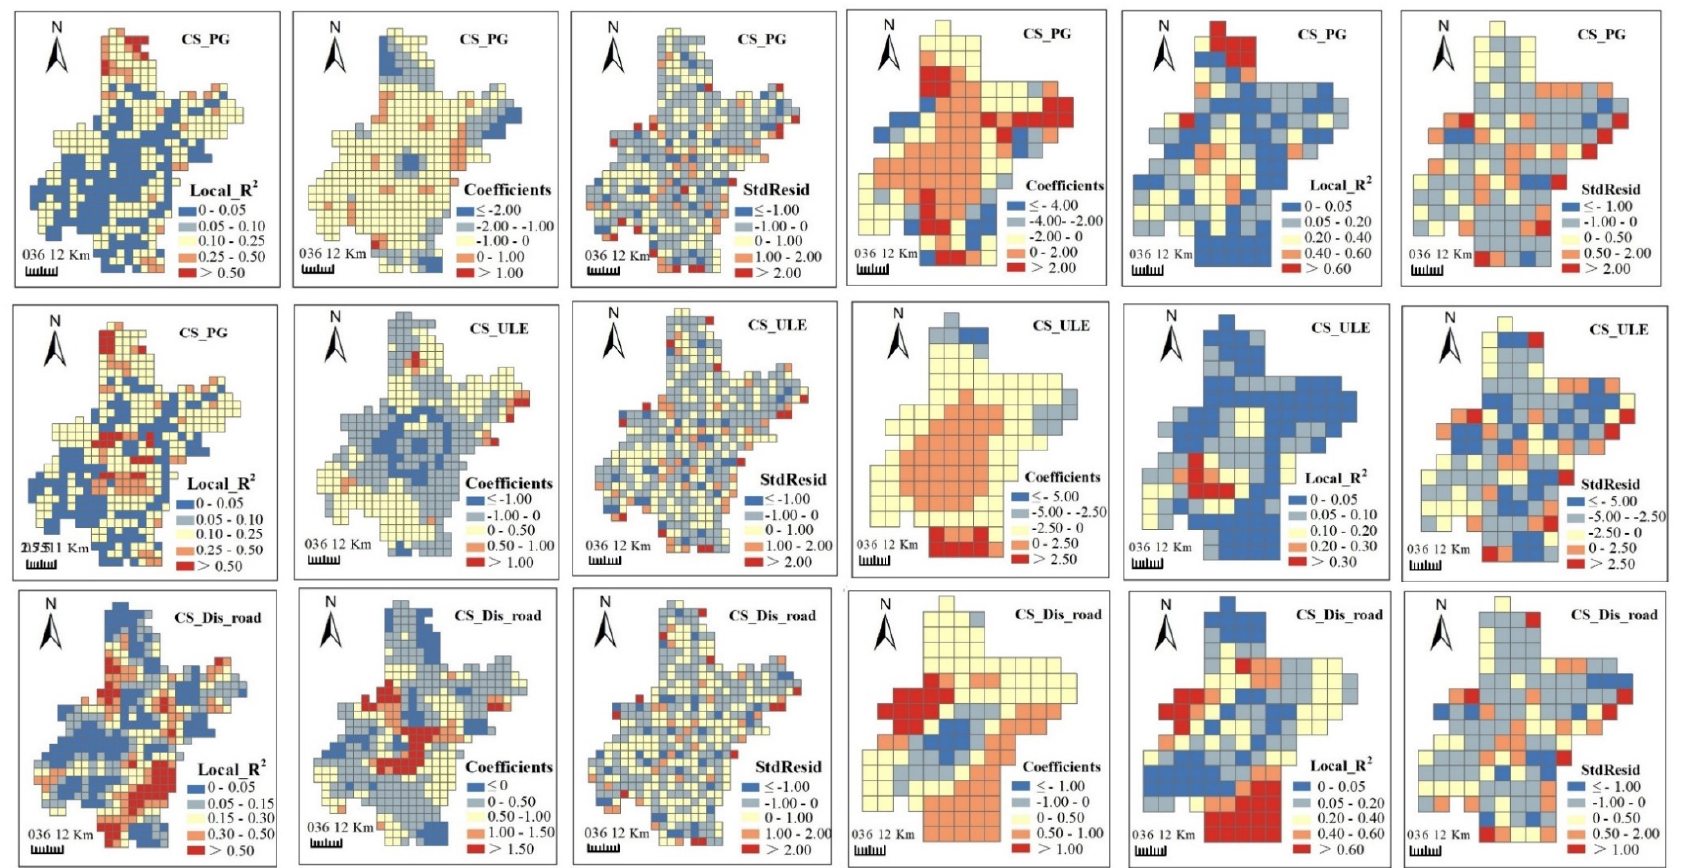
Figure 7. Spatial patterns of local R 2 , coefficients and standard residuals (StdResid) from geographically weighted regressions (GWRs) between carbon sequestration (CS) and urbanization indicators at 5 km ( left three columns ) and 10 km ( right three columns ) grid scales. Abbreviations: Population growth (PG); Urban land expansion (ULE); Distance to major roads (Dis_road).